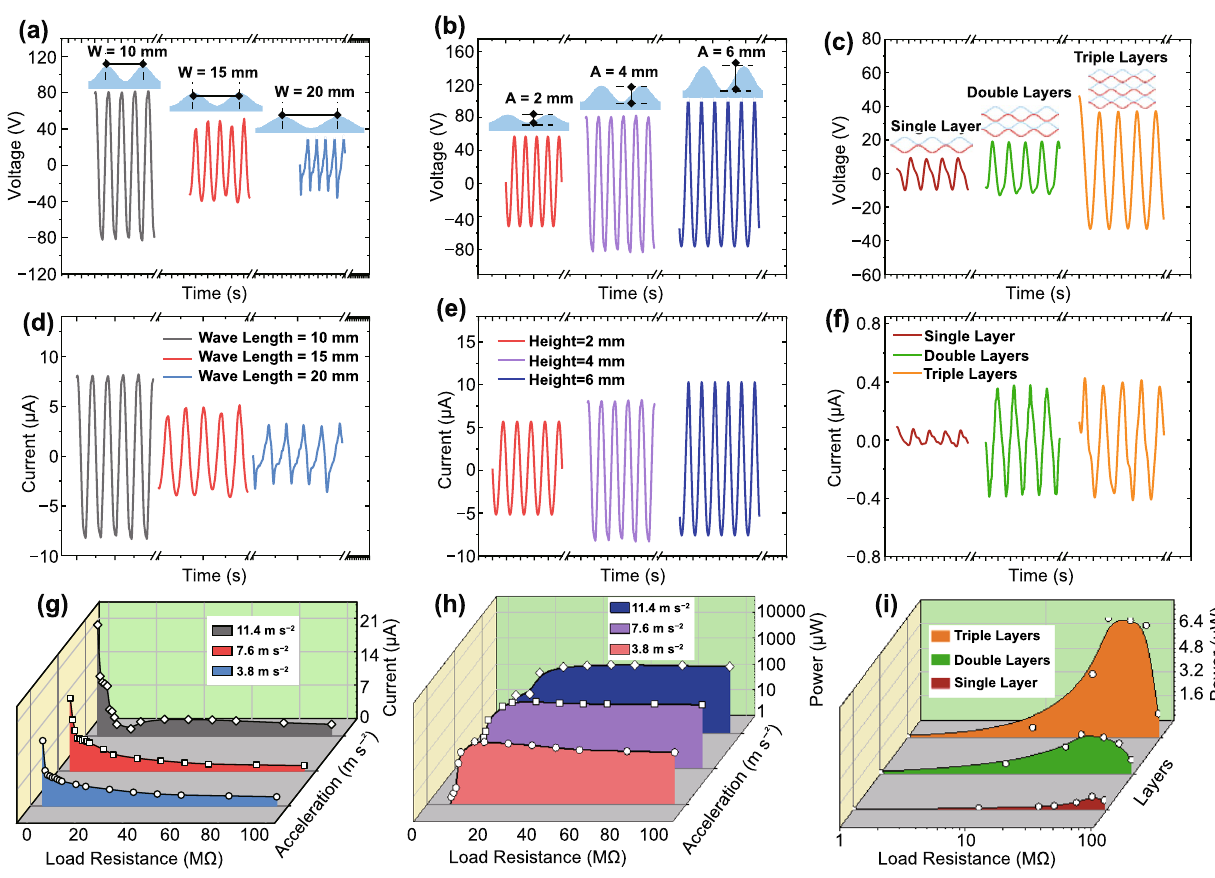
Fig. 3 Optimizations of mechanical and electrical parameters for the h-TENG: a Output voltage waveforms of h-TENG at a constant wave amplitude of 4 mm and different wavelengths ranging from 10 to 20 mm. b Output voltage waveforms of h-TENG with a constant wave wave- length of 15 mm and different amplitudes of 2 mm, 4 mm, 6 mm. c Output voltage waveforms of h-TENGs with from a single-layer wavy thin films to triple-layer films. d – f The corresponding output currents of h-TENG with different wavelengths, amplitudes and layers of wavy PET/ AgNWs/FEP composites. g , h Output current and power optimizations with varying accelerations of excitation and load resistances. i Output power optimizations with different layers and load